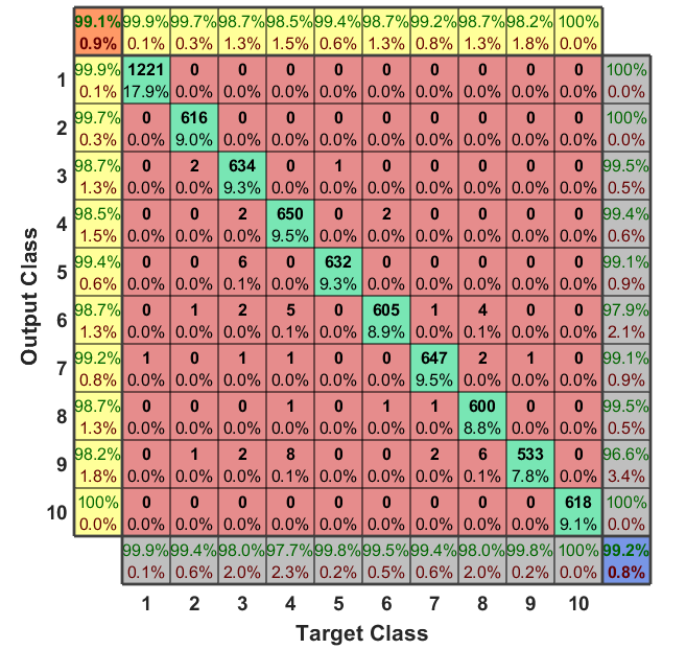
Figure 12. The output confusion matrix for 10-classes scenario (presence of the UAV, type of the UAV, and flight mode of the